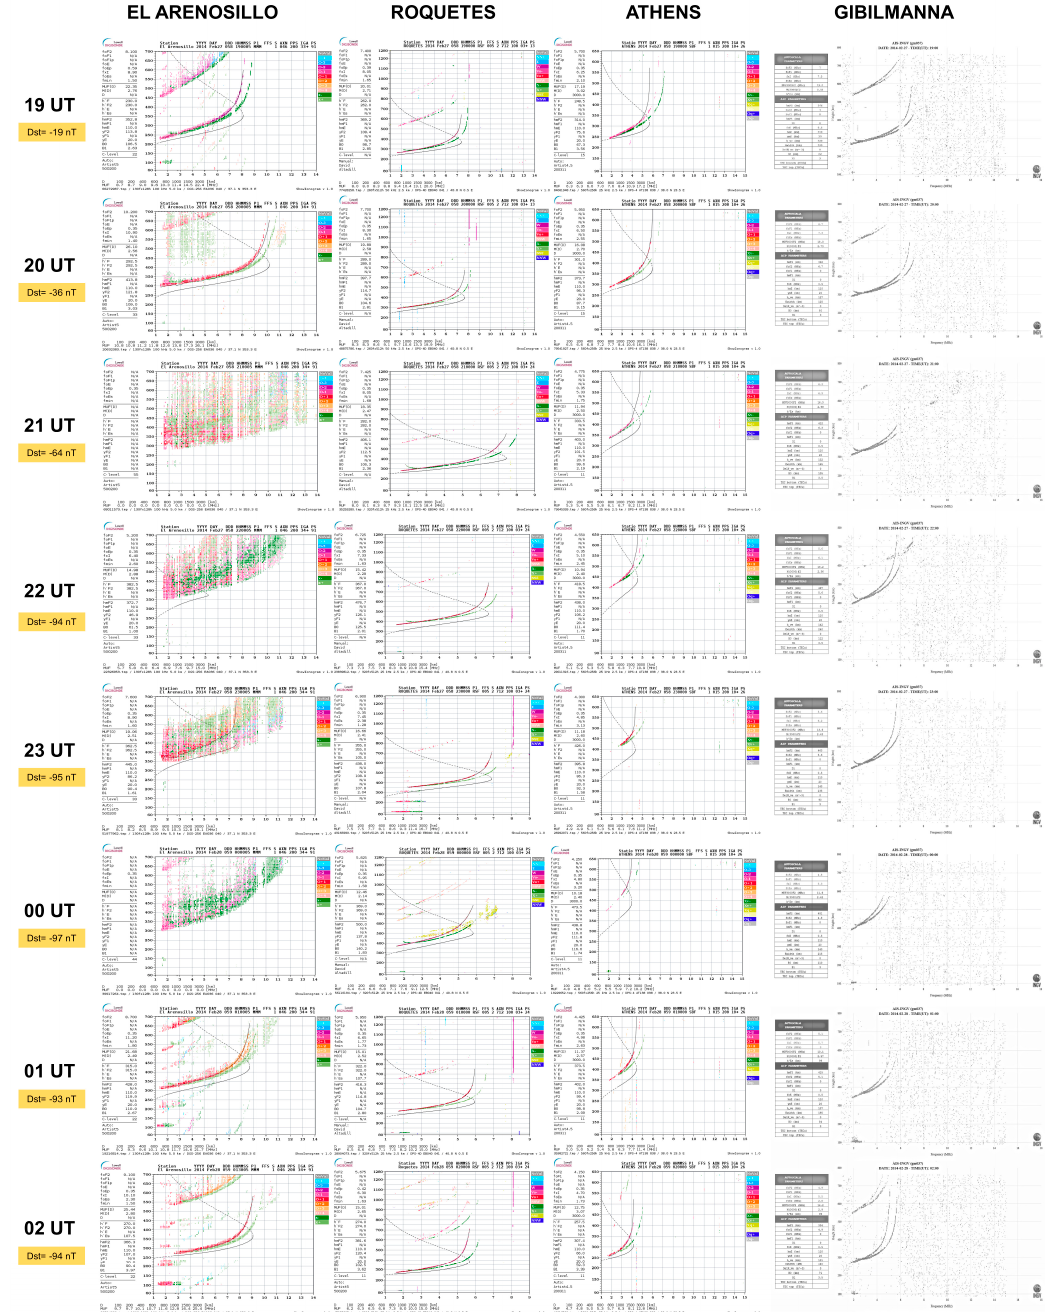
Figure 3. Ionograms (height in km vs. frequency in MHz) every 1 hr from different ionosondes: El Arenosillo (first column), Roquetes (second column), Athens (third column) and Gibilmanna (fourth column), during the main phase of the 26 – 27 February 2014 geomagnetic storm. Legends on the left side indicate the automatically scaled parameters of the ionograms. In El Arenosillo, Roquetes and Athens ionograms, information about MUF (Maximum Usable Frequency) for oblique propagation to a corresponding range is provided in the bottom part. Colours indicate directions of the ionospheric returns and Doppler shift of overhead ordinary and extraordinary ionospheric returns. In the top part, information about the ionosonde and the date and time of the ionogram can be found in the four columns for each ionogram. Although in this work the scaled parameters of the ionograms are not analysed, we have preferred to maintain this information because ionograms are directly provided by the DIDbase web portal from GIRO and the eSWua web portal from INGV.